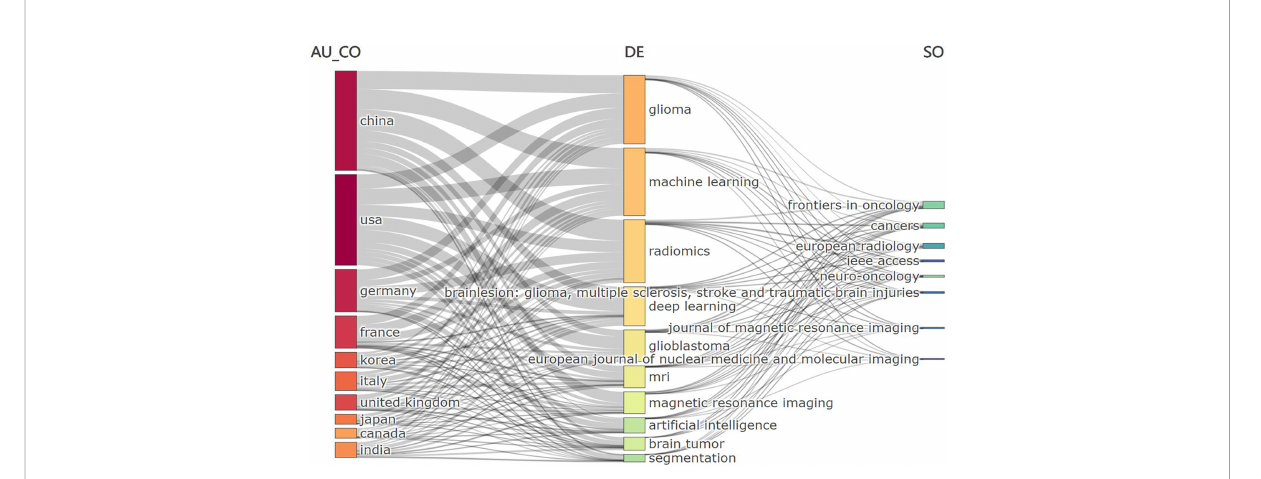
FIGURE 8 The left column represents countries. The middle column represents keywords of the publications. The right column represents journals.